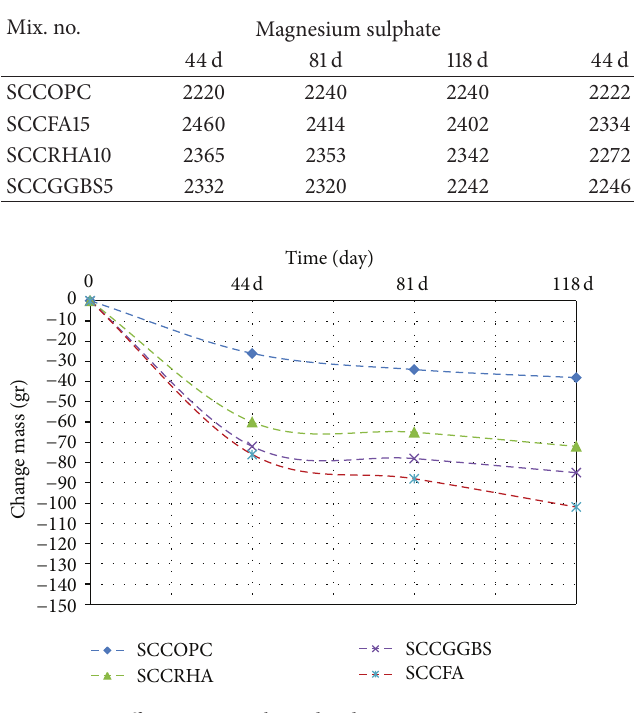
Figure 4: Effect on MS with air dried at SCC containing SCM.